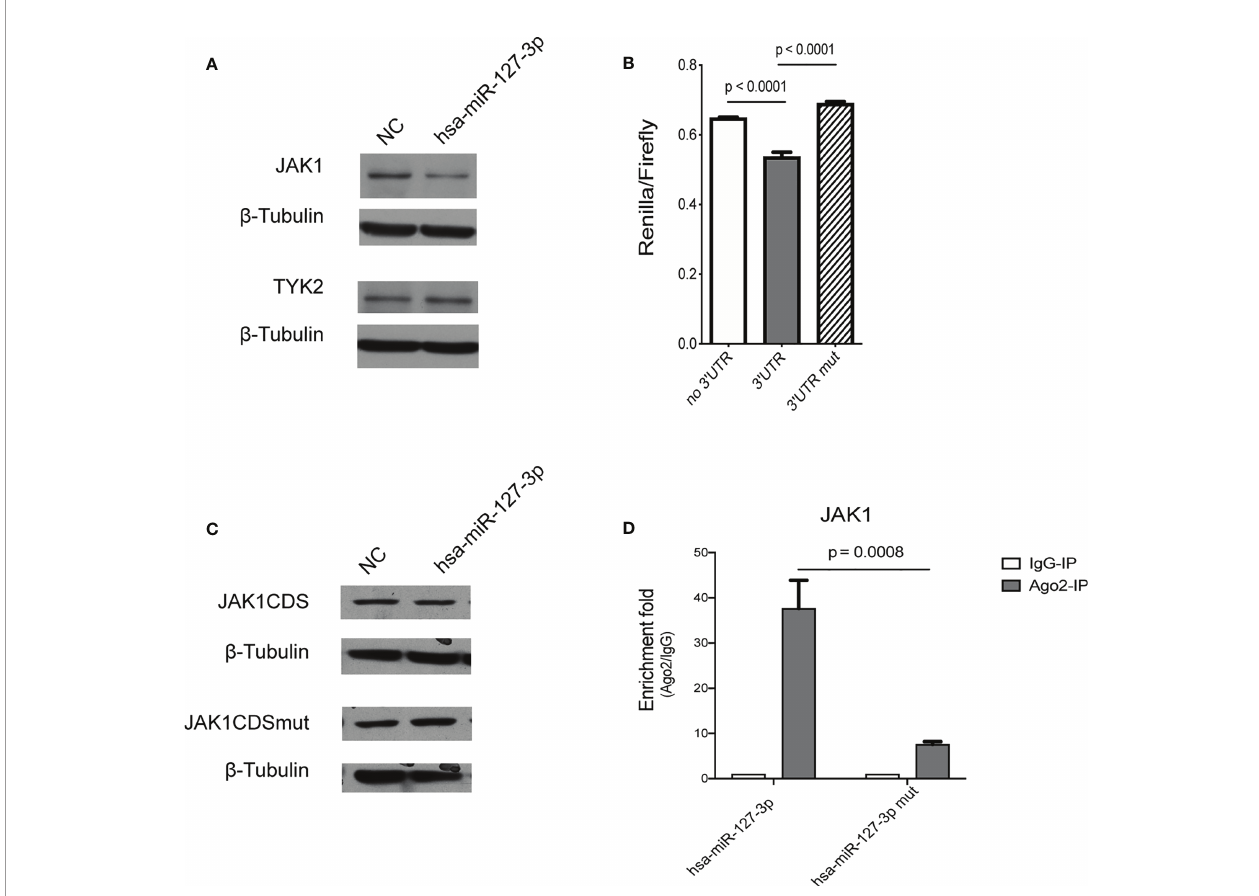
FIGURE 3 | JAK1 is a bona fi de target gene of hsa-miR-127-3p. (A) Hela cells were transfected with negative control mimics (NC) or hsa-miR-127-3p mimics and then cultured for 24 h. Whole cell lysates were prepared, and Western blot was performed for JAK1, TYK2, and b -Tubulin. (B) Hela cells were transfected with psiCHECK2, psiCHECK2-JAK1-3 ’ UTR, or psiCHECK2-JAK1-3 ’ UTR-mutant plasmids together with hsa-miR-127-3p mimics and then cultured for 24 h. Cell lysates were prepared, and fi re fl y and renilla luciferase activities were measured. The ratio of renilla to fi re fl y luciferase activity was calculated for each sample. (C) U4A cells were transfected with pcDNA3.1-JAK1t, or pcDNA3.1-JAK1t-mutant plasmids together with negative control mimics (NC) or hsa-miR-127-3p mimics and then cultured for 24 h. Whole cell lysates were prepared, and Western blot was performed for wild type HA-tagged JAK1 truncates (JAK1CDS), mutated HA-tagged JAK1 truncates (JAK1CDSmut), and b -Tubulin. (D) Hela cells were transfected with hsa-miR-127-3p mimics or hsa-miR-127-3p mutant mimics (mut) and then cultured for 12 h. Cell lysates were prepared, and RNA immunoprecipitation was performed. The levels of JAK1 mRNA were quanti fi ed for each sample. And the enrichment fold of JAK1 mRNA in anti-Ago2 antibody pull-down products compared to IgG was calculated. (A, C) Representative pictures from at least 3 independent experiments. (B, D) Data from at least 3 independent experiments are plotted and presented as mean±SEM. P values were determined by Mann- Whitney